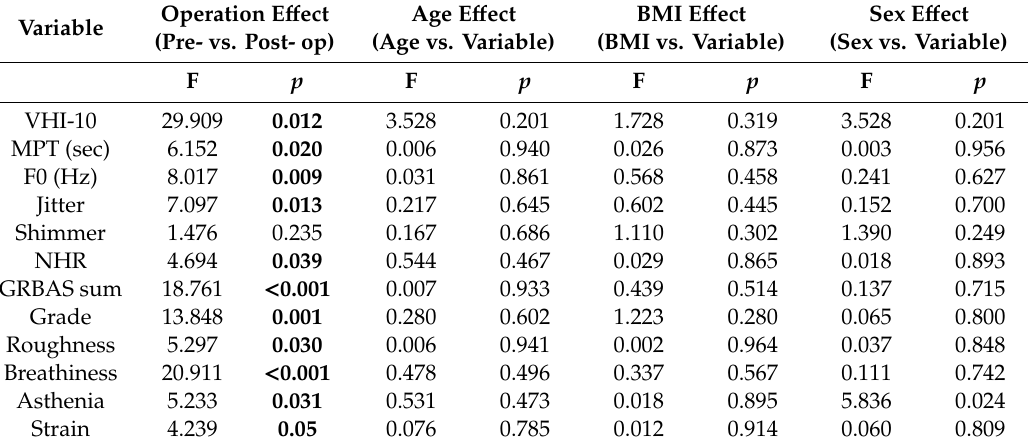
Table 6. Repeated-measures ANOVA for analysis of di ff erent e ff ect on